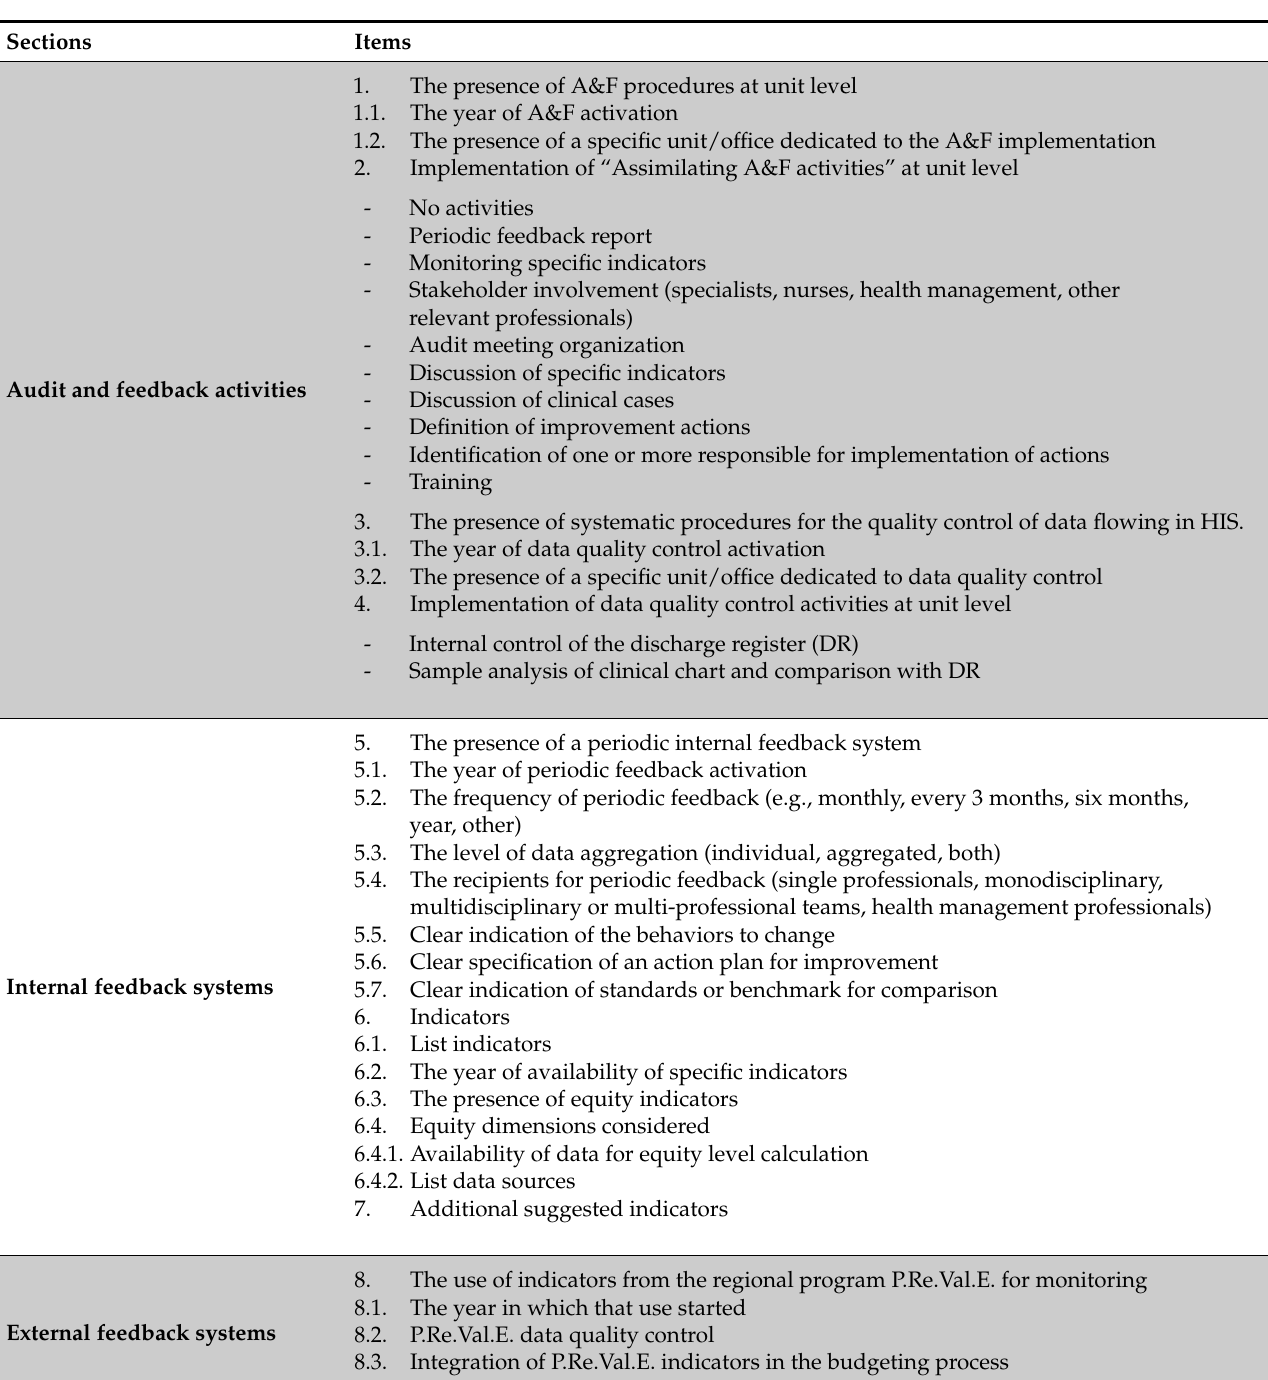
Table 1. Investigated Audit and Feedback